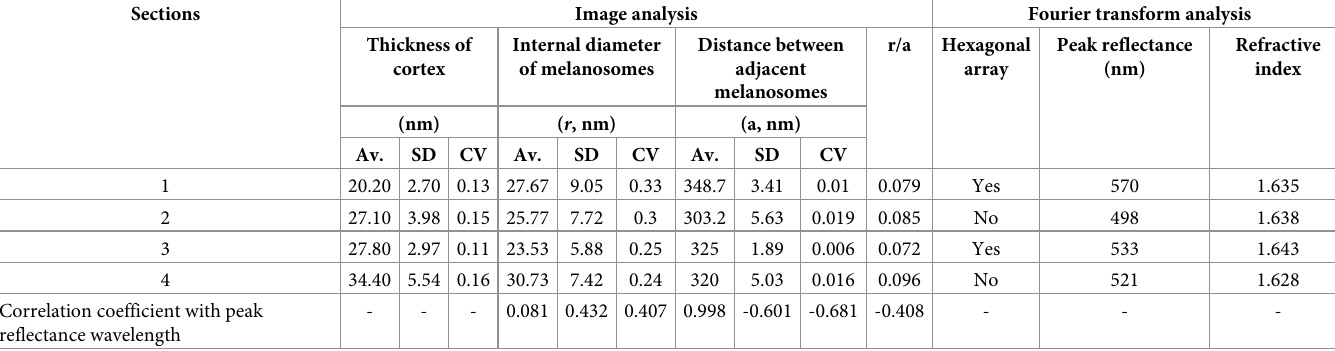
Table 1. Relationship between the structural parameters and the wavelength of the peak reflectance predicted from Fourier transform analysis. Sections